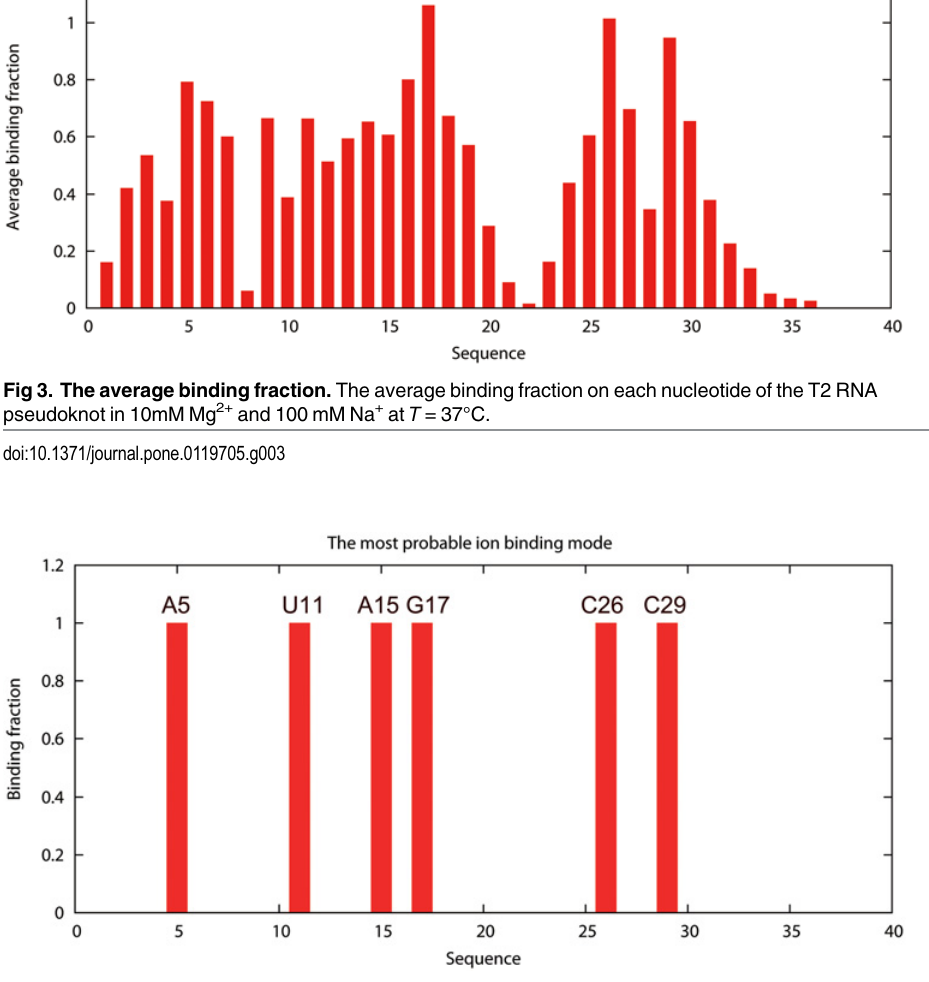
Fig 4. The most probable binding mode for the tightly bound ions. The lowest energy ion binding mode for the T2 RNA pseudoknot at [Mg 2+ ] = 10mM, [Na + ] = 100mM, T = 37°C. The most probable binding sites (nucleotides) are denoted with the orange color in the inset.